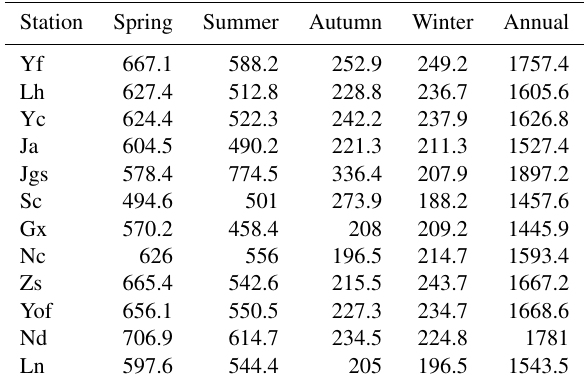
Table 2. Seasonal and annual mean precipitation in stations (mm). The data are based on the selected period